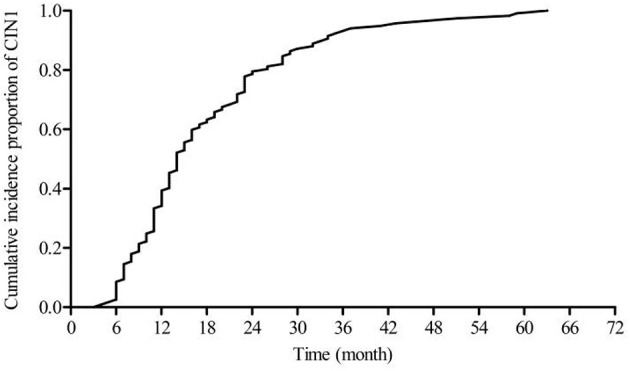
Cumulative proportion of CIN1.